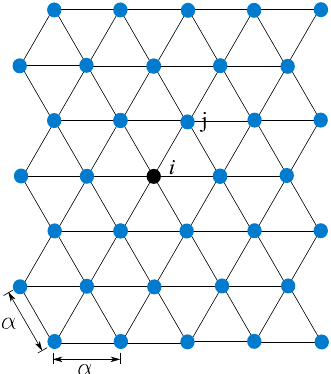
Figure 5. Regular triangular lattice of spacing α .